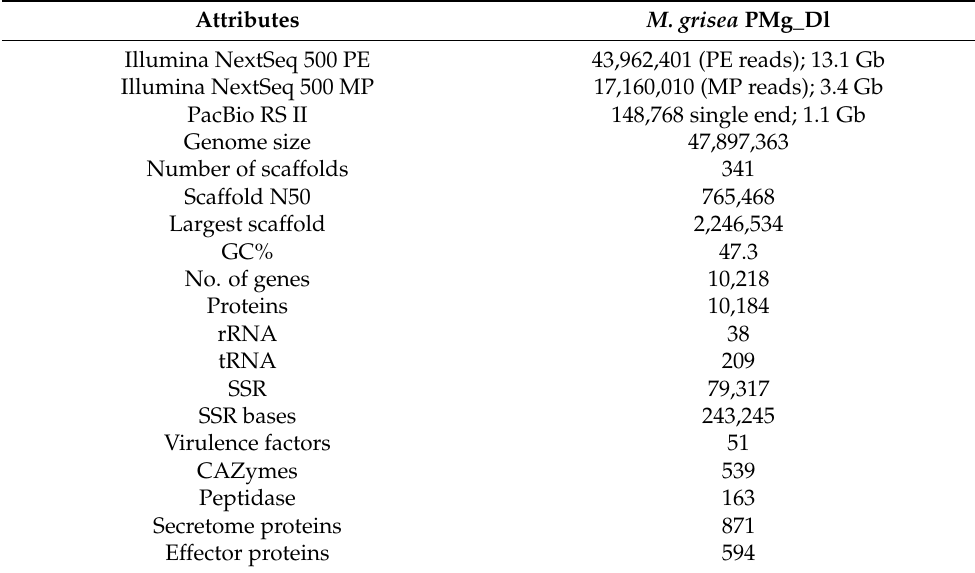
Table 1. General features of the assembled whole genome of M. grisea